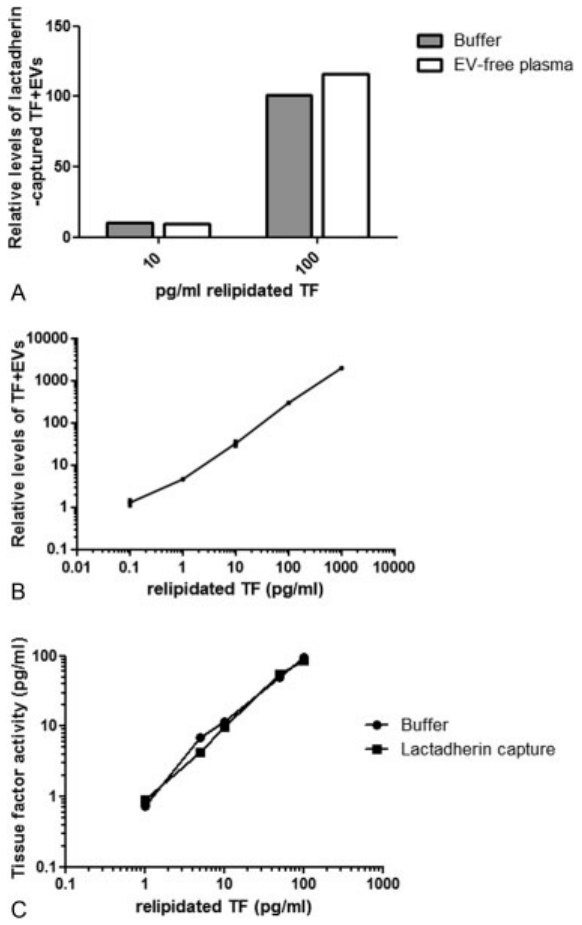
Fig. 7 Detection of PS þ TF þ EVs using SP-PLA and lactadherin capture. ( A ) Relipidated TF was spiked into buffer or EV-free plasma and detected with SP-PLA after lactadherin capture. Levels relative to control with EV-free plasma (set to 1) are shown. ( B ) Relipidated TF was spiked at different concentrations in PLA buffer and TF þ EVs were detected with SP-PLA after lactadherin capture. Error bars represent standard deviation from technical replicates ( n ¼ 2). ( C ) TF PCA of relipidated TF was measured using a direct activity assay after capture directly in the buffer or after lactadherin